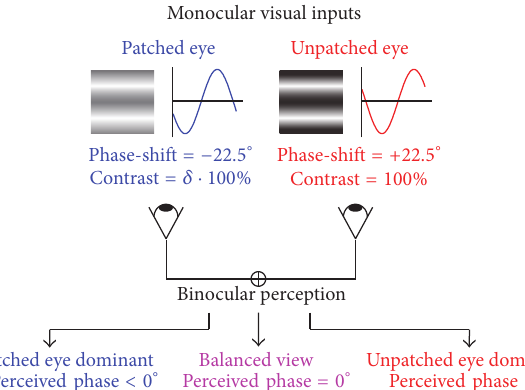
Figure 1: The binocular phase combination paradigm. As illustrated in the figure, two horizontal sine-wave gratings with equal and opposite phase-shift of 22.5 ∘ relative to the centre screen were dichoptically presented to the two eyes, and the binocular perceived phase would be 0 ∘ when the two eyes are balanced. In our study, we set the phase-shift of the grating to − 22.5 ∘ in the patched eye and to 22.5 ∘ in the unpatched eye. After patching, if the patched eyebecamestronger,thebinocularlyperceivedphasewouldbemore minus; otherwise, if the patched eye became weaker, the binocularly perceived phase would be more